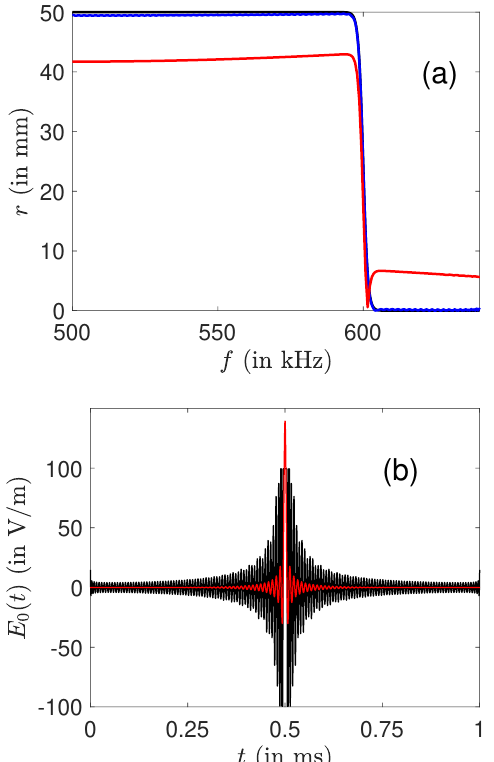
Figure 3. ( a ) The final radius r as a function of the frequency f . The black, blue (dark gray) and red (light gray) curves represent, respectively, the ideal profile, the one obtained with the optimization algorithm and the one corresponding to the optimal pulse of Figure 1 whose amplitude has been abruptly limited (see the text for details). Note that the black and blue lines in ( a ) are almost superimposed. The amplitude E 0 of the optimal fields in the rotating frame with (black curve) and without (red or light gray curve) constraints are depicted in ( b